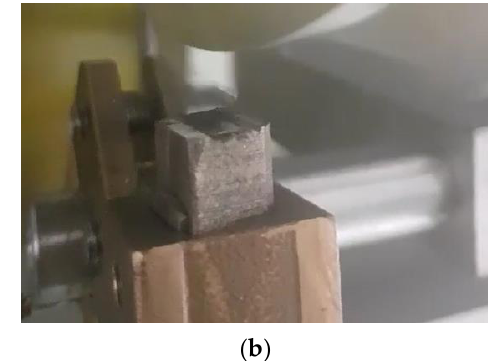
Figure 8. Photo of spark generation for saw-tooth-shaped plate: ( a ) passive shaft-grounding device and ( b ) electrical pitting prevention device.